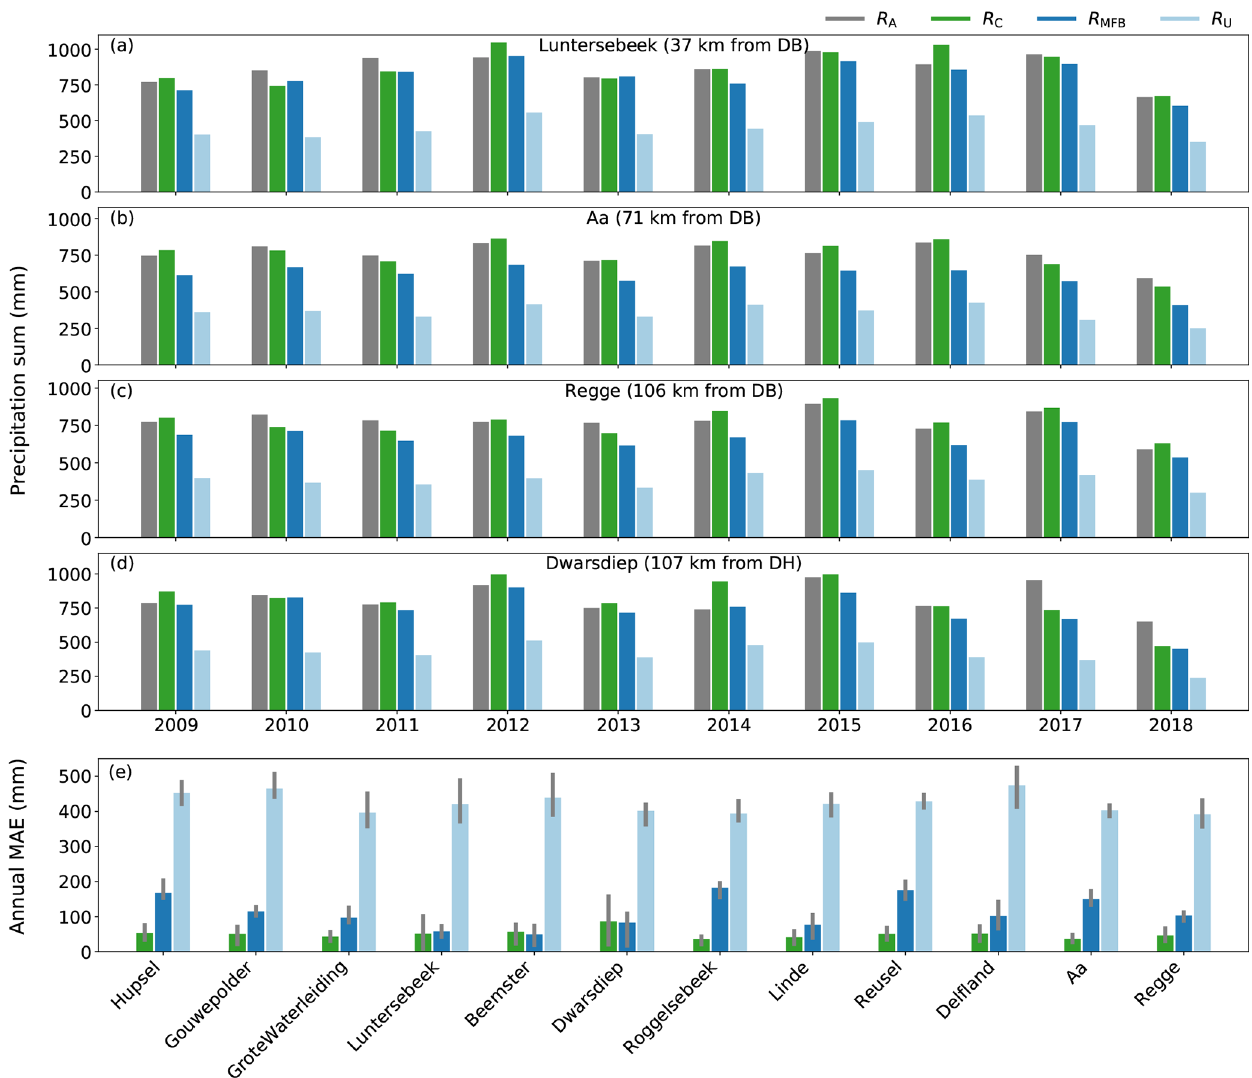
Figure 6. Effect of the adjustment factors on the catchment-averaged annual rainfall sums. (a–d) The results for a sample of four catchments that are spread over the country (and thus the radar domain): (a) Luntersebeek, (b) Aa, (c) Regge and (d) Dwarsdiep. Shown are R A (grey), the estimated rainfall sum after correction with the CARROTS factors ( R C ; green), the estimated rainfall sum after correction with the MFB- adjustment factors ( R MFB ; dark blue) and the rainfall sum with the unadjusted radar rainfall estimates ( R U ; light blue). The distance between the catchment center and the closest radar in the domain is given in the title of panels (a–d) (DH is Den Helder and DB is De Bilt). The radar in Herwijnen, which replaced the radar in De Bilt in January 2017, is not included here because this radar was operational for the shortest time in this analysis. (e) The mean absolute error of the annual precipitation sum between the QPE products and the reference rainfall sum ( R A ). The vertical grey lines, per bar, indicate the IQR of the mean absolute error (MAE) based on the 10